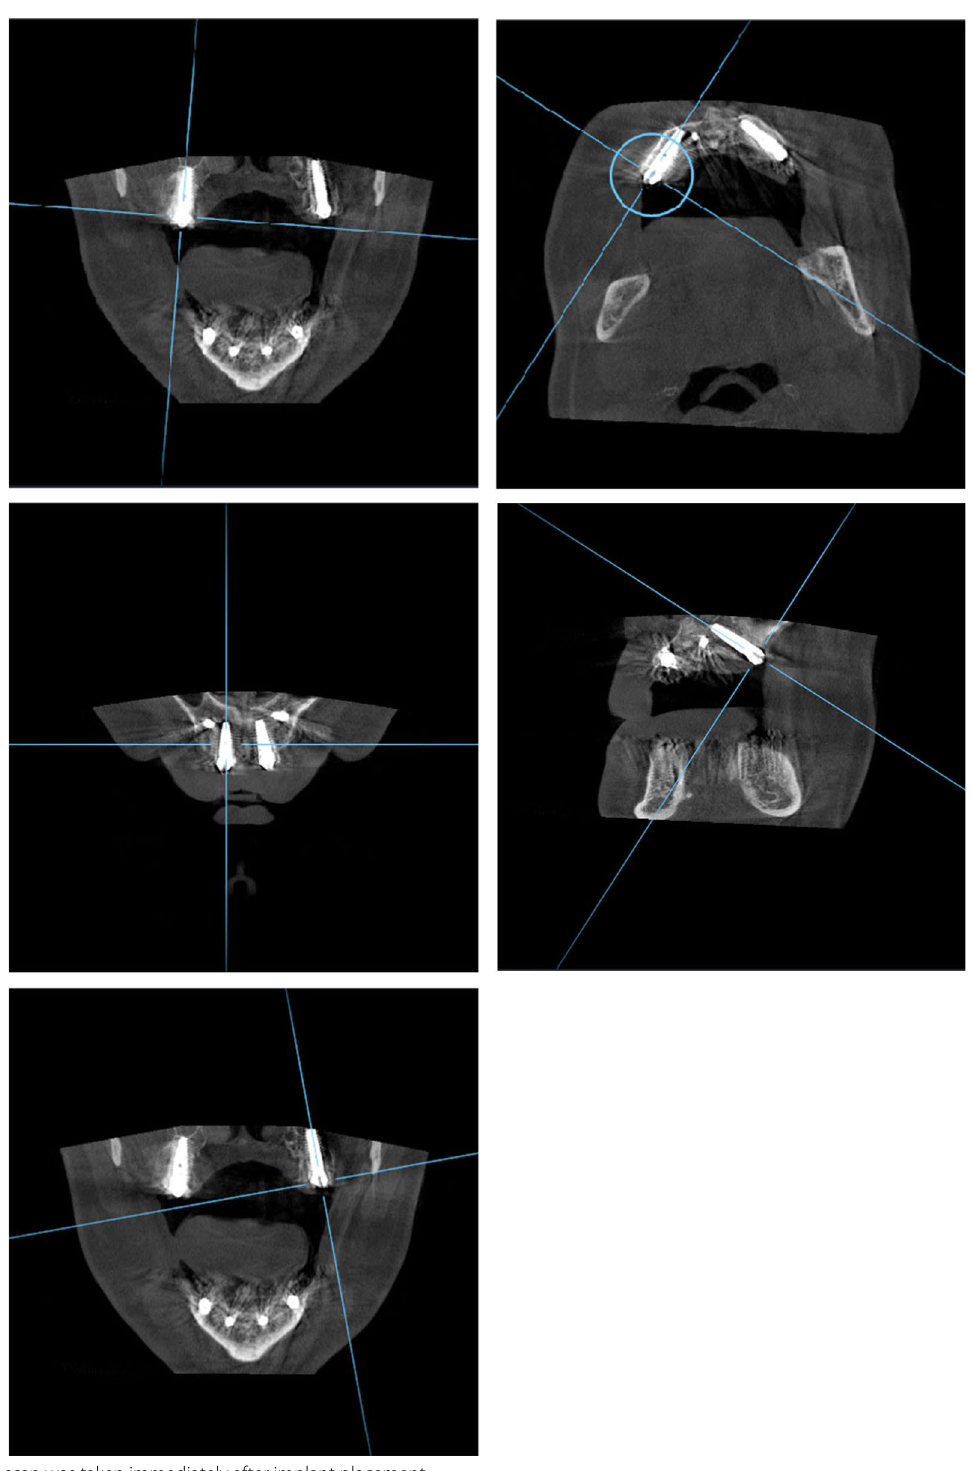
Fig. 2 CBCT scan was taken immediately after implant